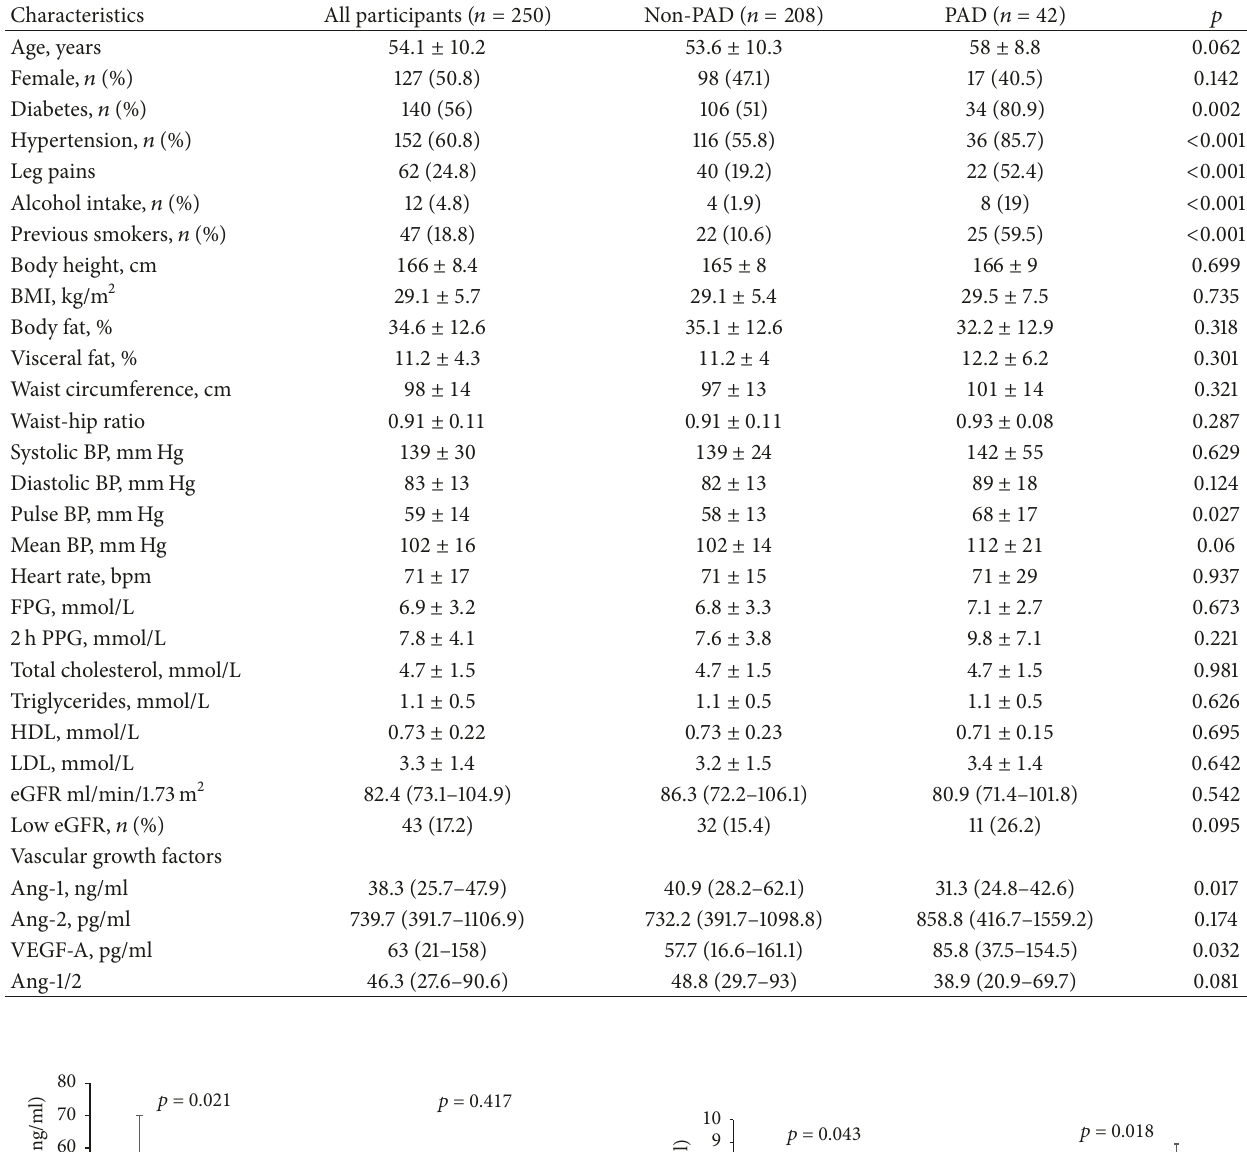
Table 2: Clinical characteristics of study participants by PAD status.